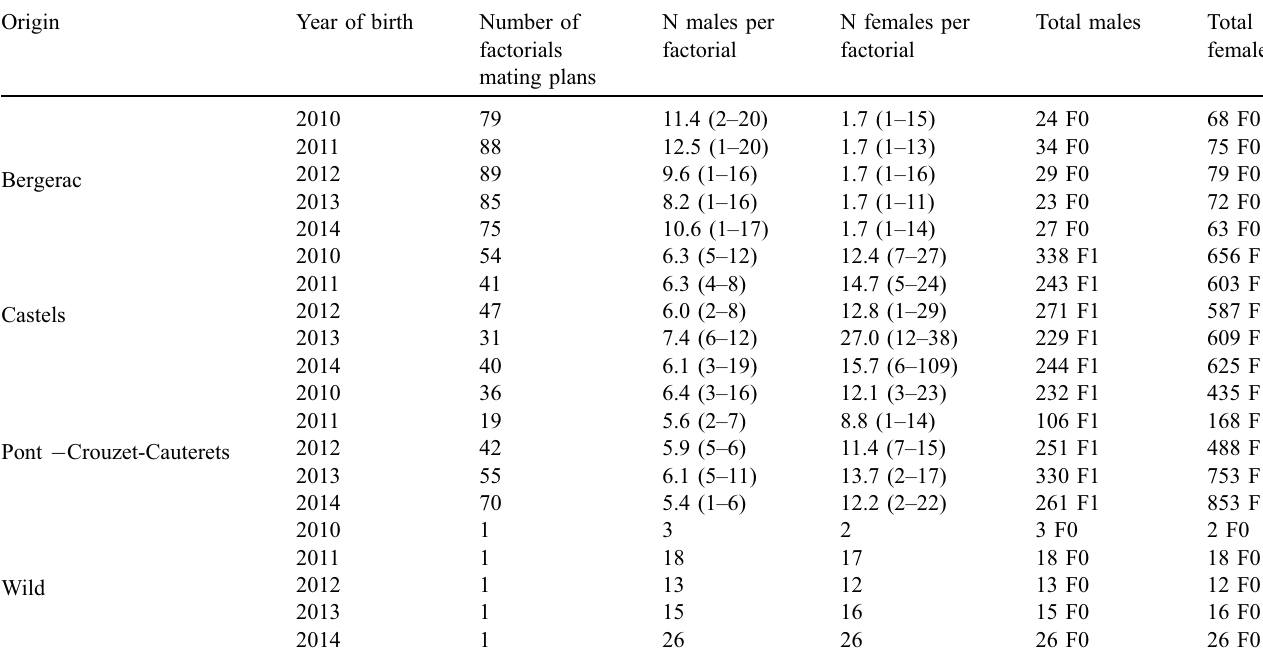
Table 3. Mating plans used to simulate salmon offspring from years of birth 2010 – 2014 in the Garonne-Dordogne basin restocking program. Origin